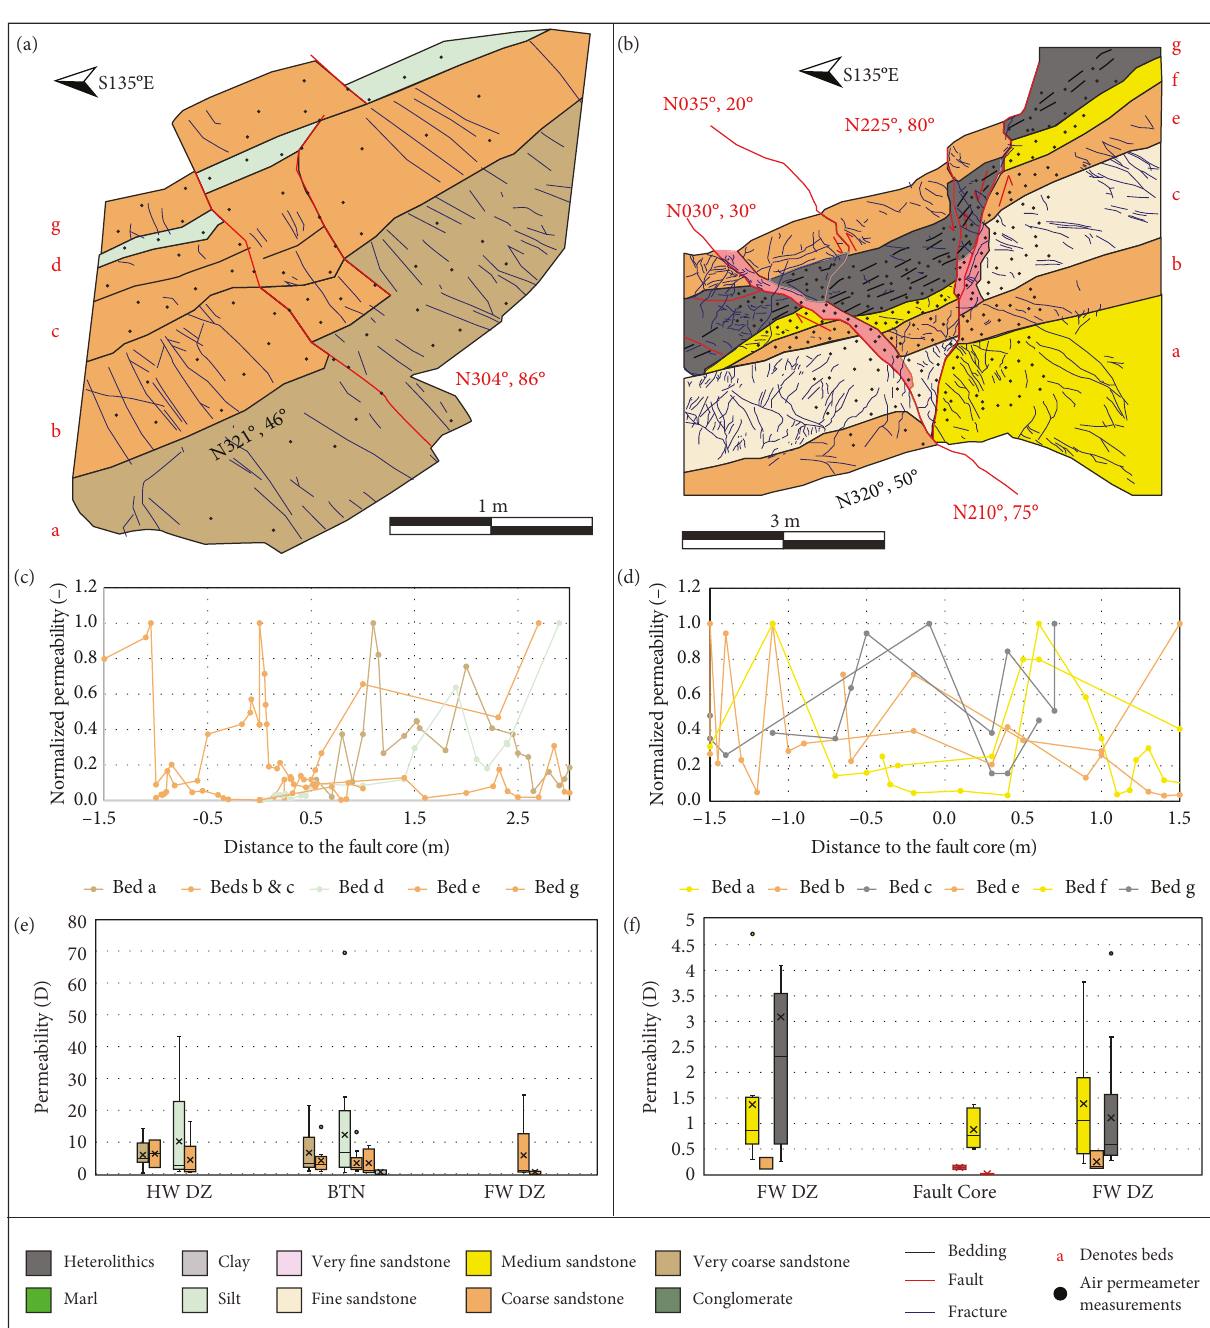
Figure 6: Permeability across complex faults in di ff erent styles of multilayer package. Fault orientation is denoted in right hand rule with red text, whereas bed orientation is in black text: line drawings of (a) the FCE faults, which cut through packages of evenly distributed clay layers, and (b) the FCU faults, which cut through packages with unevenly distributed clay layers; permeability normalized for bed thickness for (c) the FCE fault and (d) the FCU fault; variation of permeability measurements shown in a box and whisker plot, in order to show the high variability across the damage zone in the hanging wall (HW DZ), the fault core between the faults (BTN), and the damage zone of the footwall (FW DZ) in (e) the FCE fault and (f) the FCU fault. Color meaning is denoted in the legend